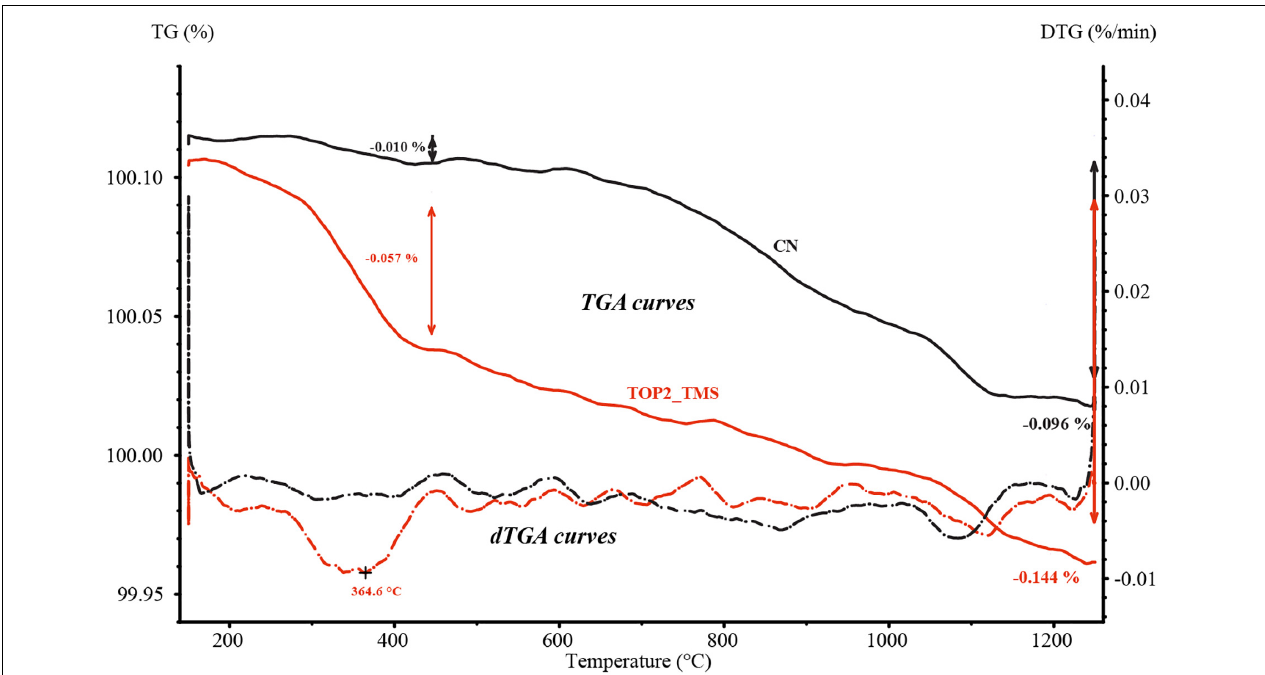
FIGURE 10 | TG and dTGA curves with temperature for TOP2-TMS and CN. Major mass loss occurred at low T (i.e., between 300 and 450 ◦ C with a peak at 364.6 ◦ C) and is far greater for TOP2-TMS (–0.057%, red arrows) than for CN (–0.010%, black arrows), which corresponds to meteoric degassing. The second mass loss occurred at high T (i.e., ± 1100 ◦ C) and is in the same range for both samples, which corresponds to a magmatic degassing.